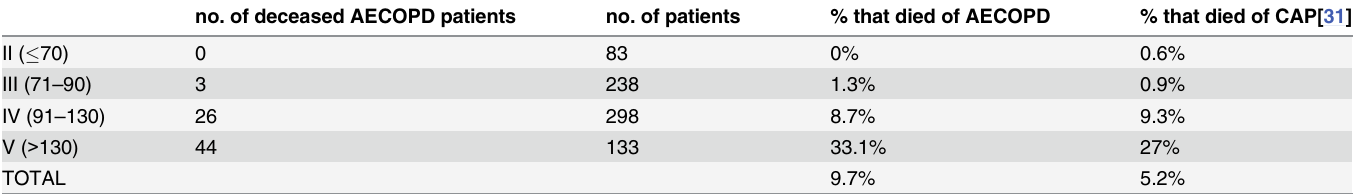
Table 5. Comparison of in-hospital mortality according to the PSI risk group in COPD exacerbation and community-acquired pneumonia. no. of deceased AECOPD patients no. of patients % that died of